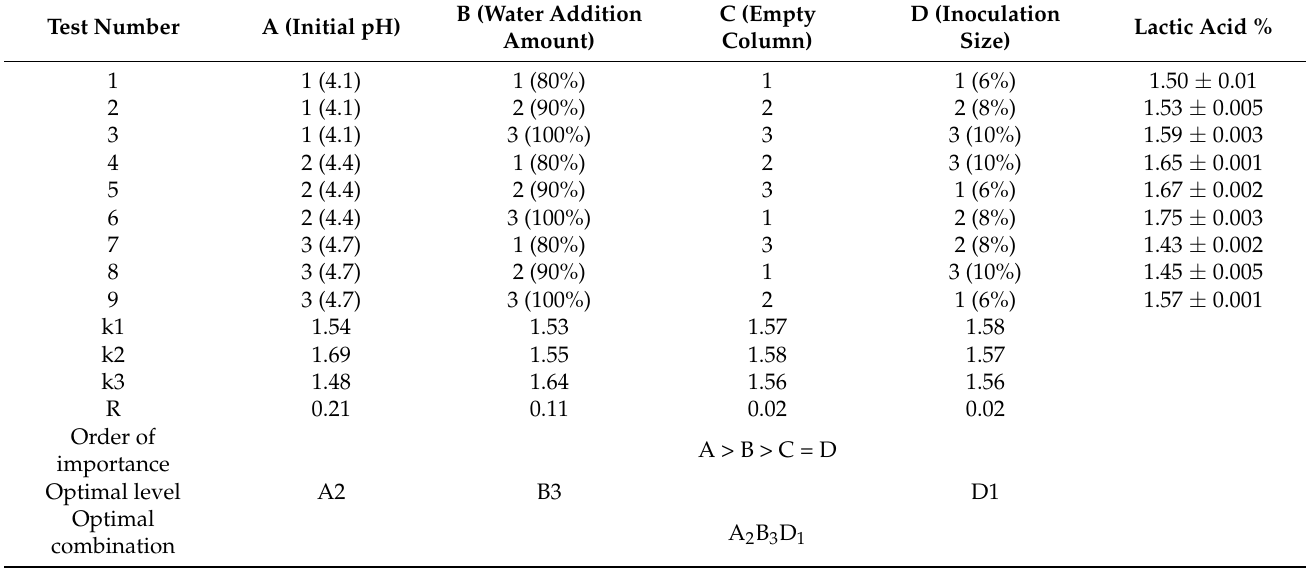
Table 7. Orthogonal test of fermentation conditions for Pediococcus acidilactici .